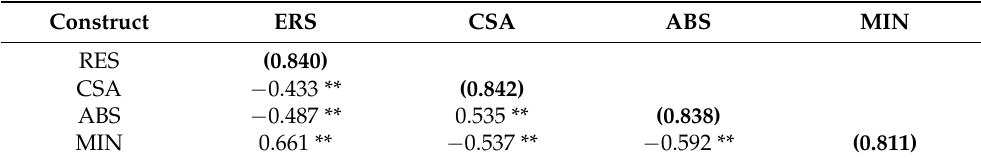
Table 3. Discriminant validity